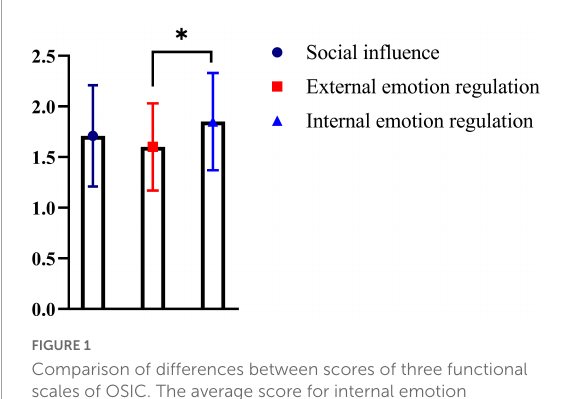
FIGURE1 Comparison of differences between scores of three functional scales of OSIC. The average score for internal emotion regulation was significantly higher than external emotion regulation ( p = 0.03 ) ∗ p <